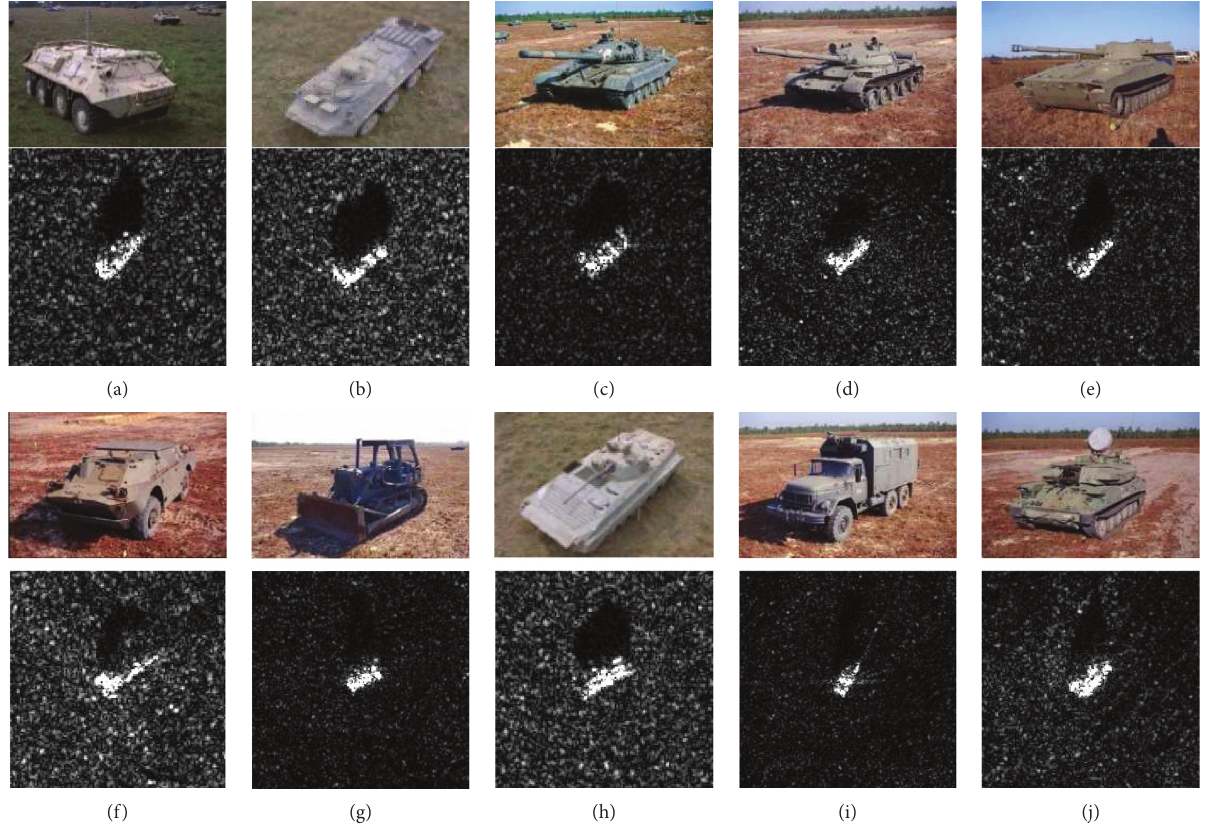
Figure 12: Optical image (top) and SAR image (bottom) of ten types of vehicle